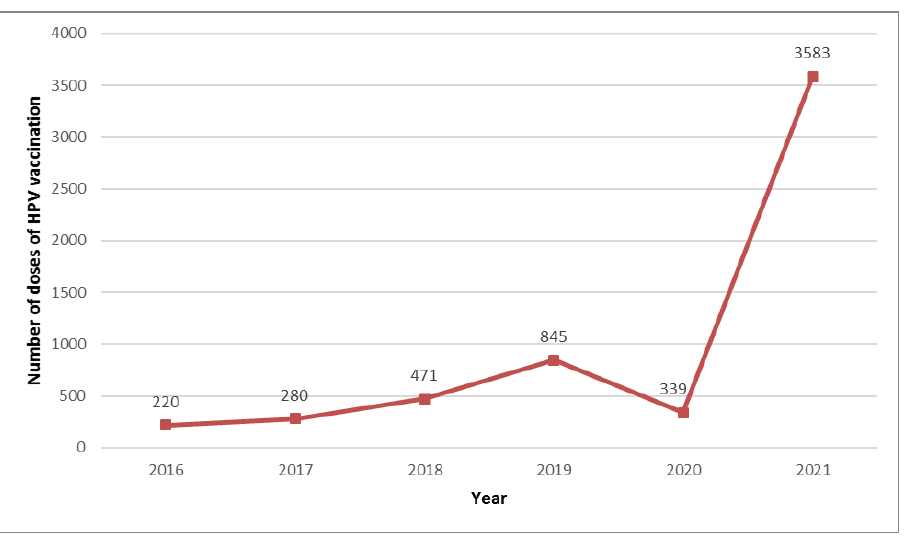
Figure 3. Number of doses of HPV vaccination administered (private health care).